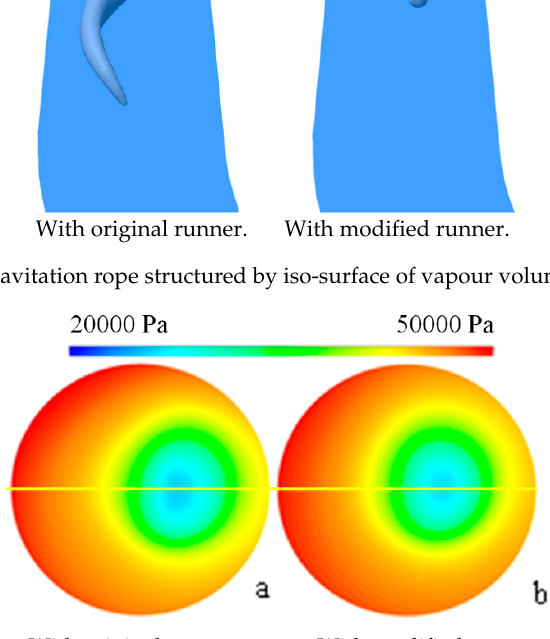
With original runner. With modified runner. Figure 9. Pressure distribution in monitor section S1-1 at σ = 0.12.